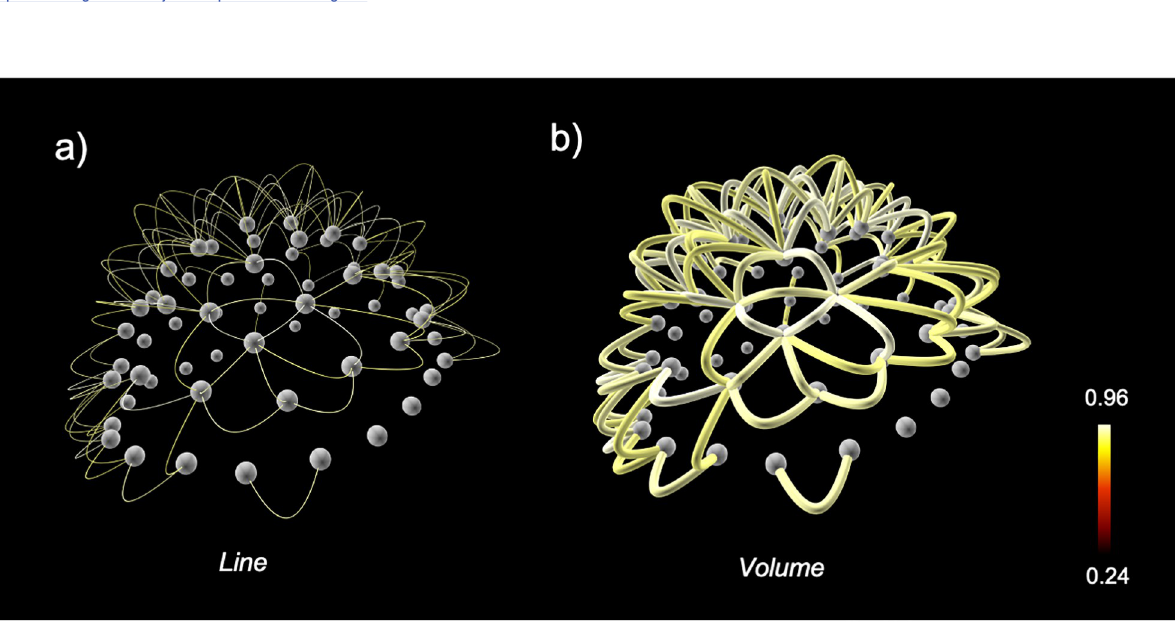
PLOS ONE | https://doi.org/10.1371/journal.pone.0282181 March 23,